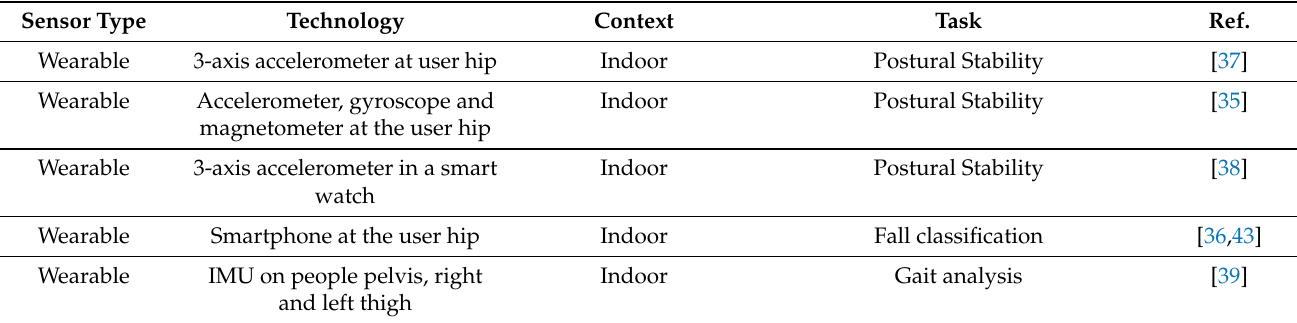
Table 1. Principal technologies applied in various contexts to create different health assistance tasks. Sensor